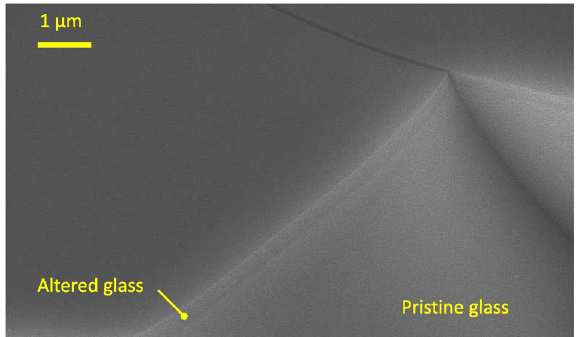
Fig. 5 SEM cross section of the alteration layer formed on ISG exposed for 209 days to pH 9 solution saturated with silica at 90 °C. (reproduced with permission from ref. 35 , copyright Elsevier 2017)